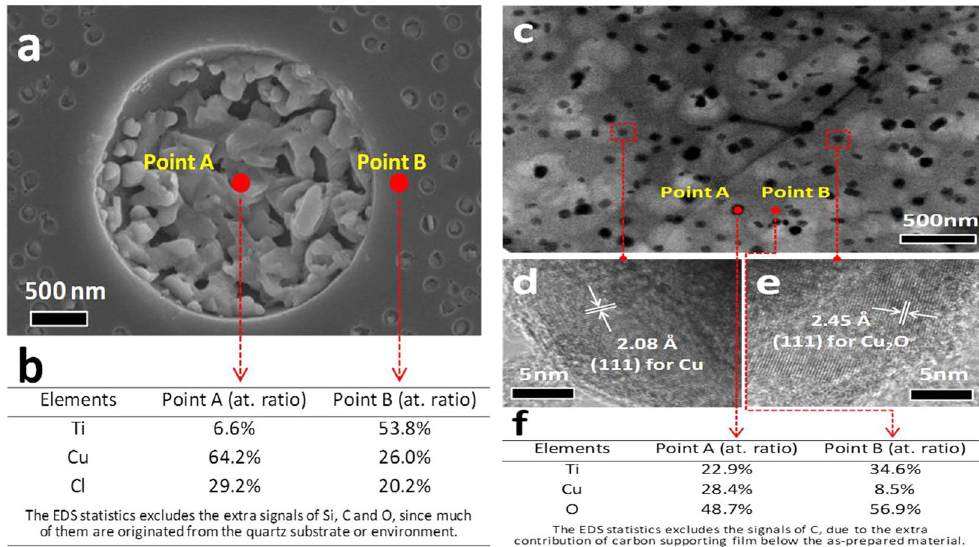
Figure 6. Microstructure and composition analysis ( a ) SEM image of the sample annealed at 150 °C in air ( b ) EDS ( c ) the overview TEM image of the sample annealed at 600 °C in vacuum ( d , e ) HRTEM ( f )